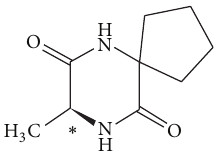
Figure 1: Structure of ( S